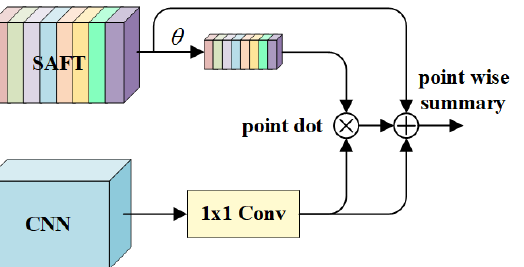
Figure 3. Structure diagram of global feature refinement module, θ is global average